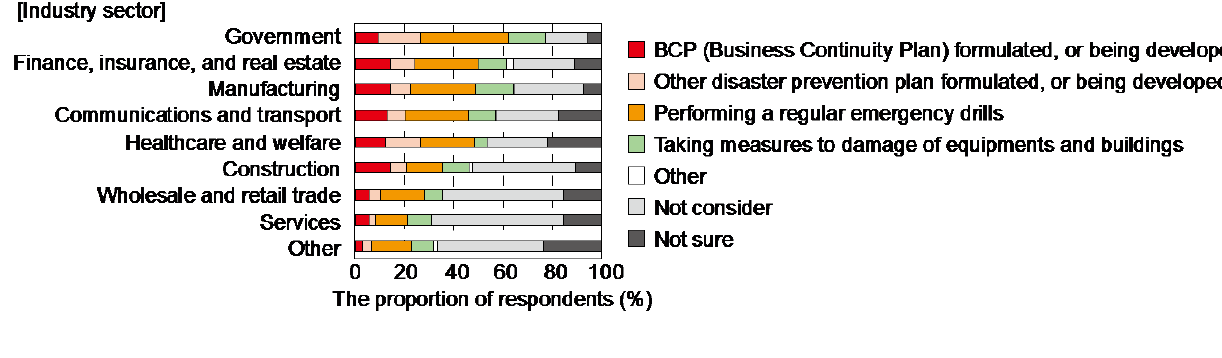
Figure 1. Disaster-preparedness measures on the part of business firms noted in response.